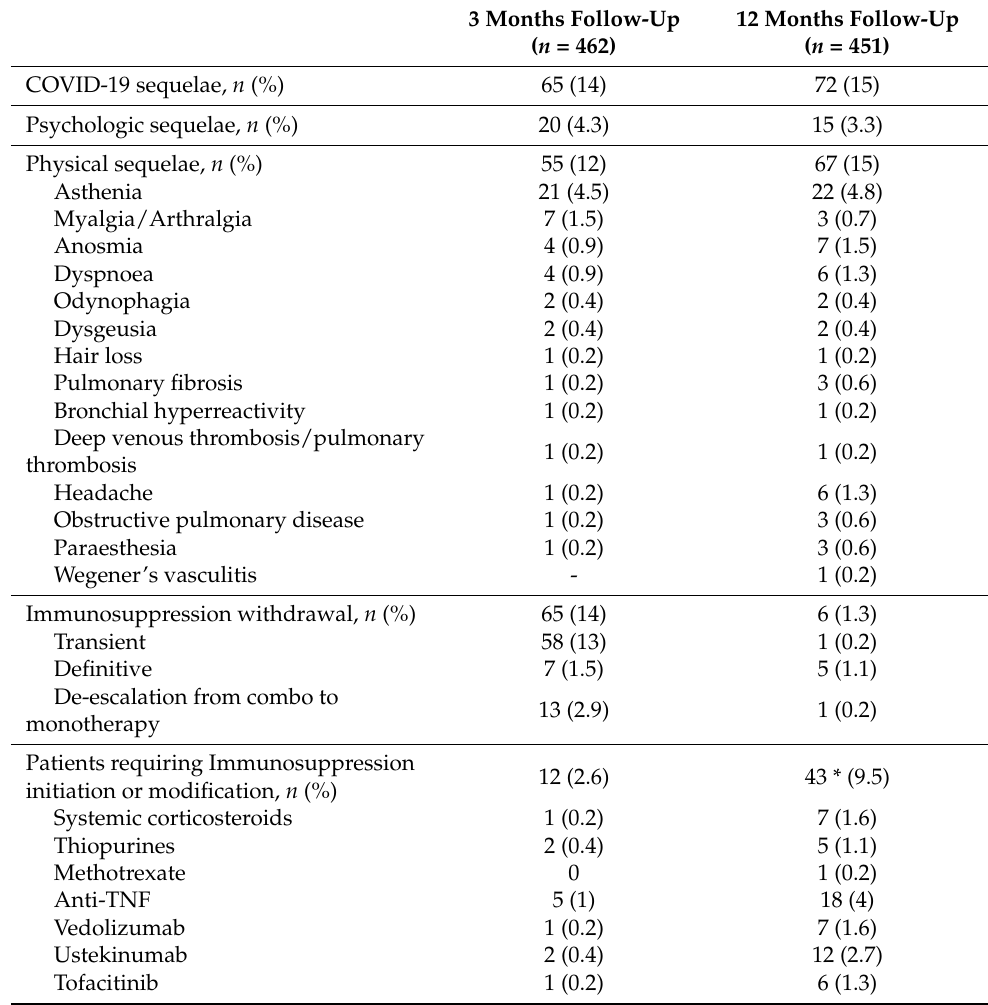
Table 6. Sequelae at 3- and 12-months of COVID-19 and the impact of the infection on changes in therapeutic regimens for